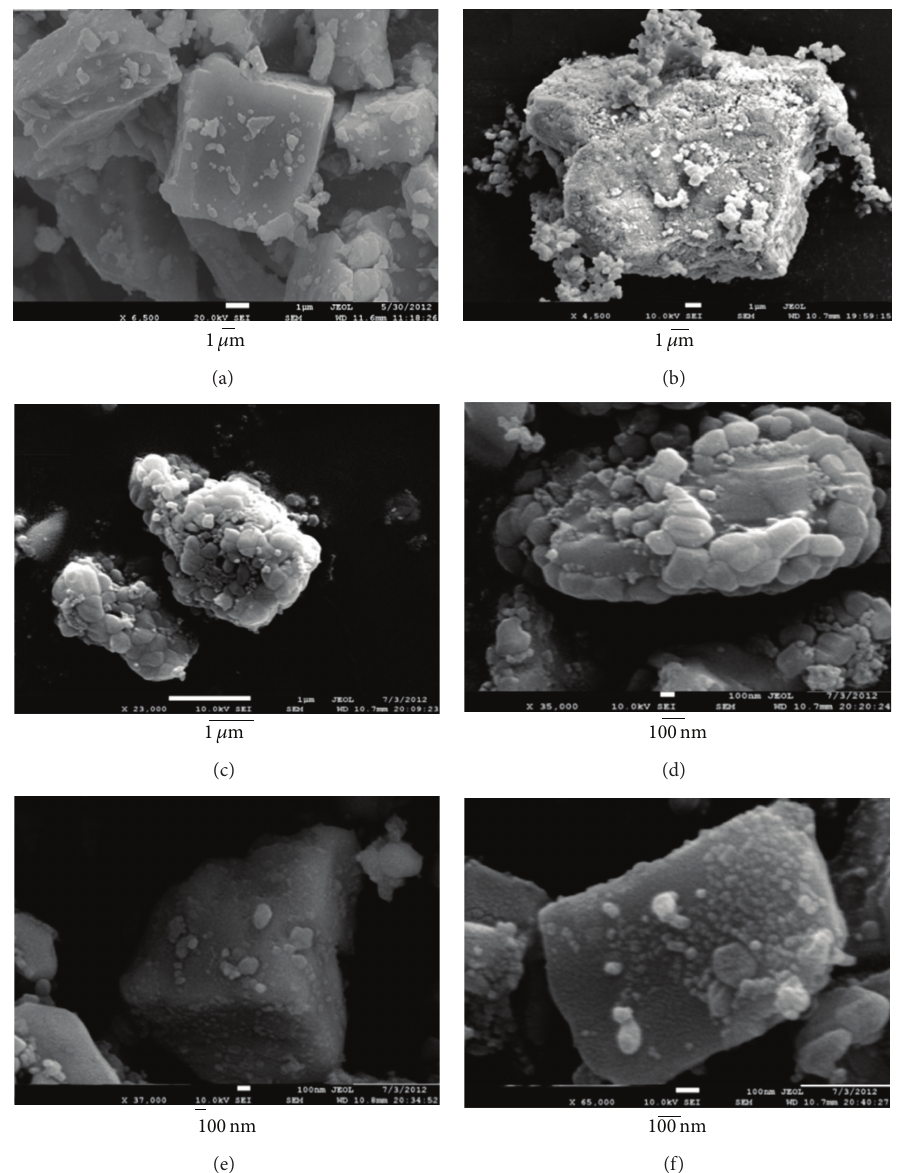
Figure 3: SEM images of naked barite (a), 30 min of grinding (b), 60min of grinding (c), 90 min of grinding (d), 120min of grinding (e), and 150 min of grinding